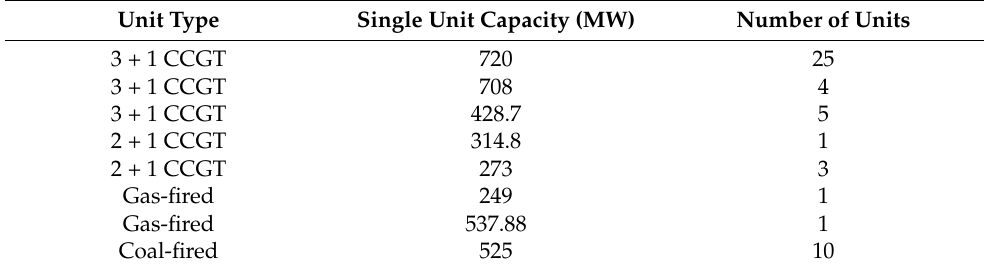
Table 1. Original case for generating